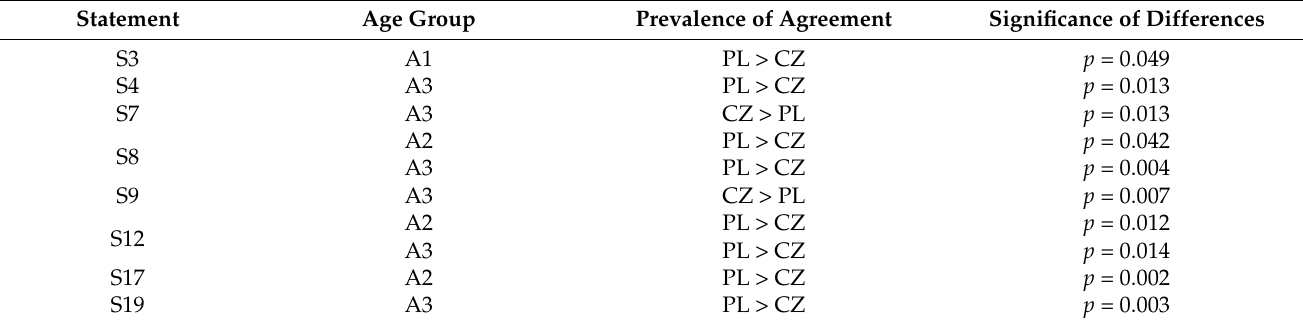
Table 5. Analysis of the prevalence of agreement with statements by nationality and age.